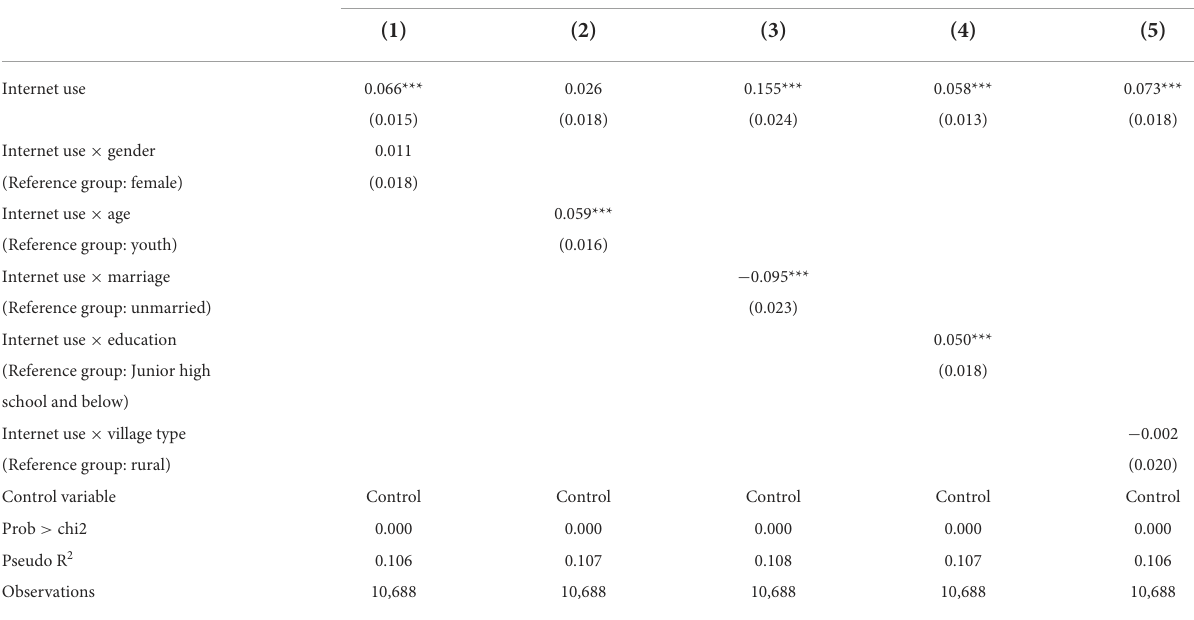
TABLE 5 Internet use impacts the heterogeneity of residents’ sport participation